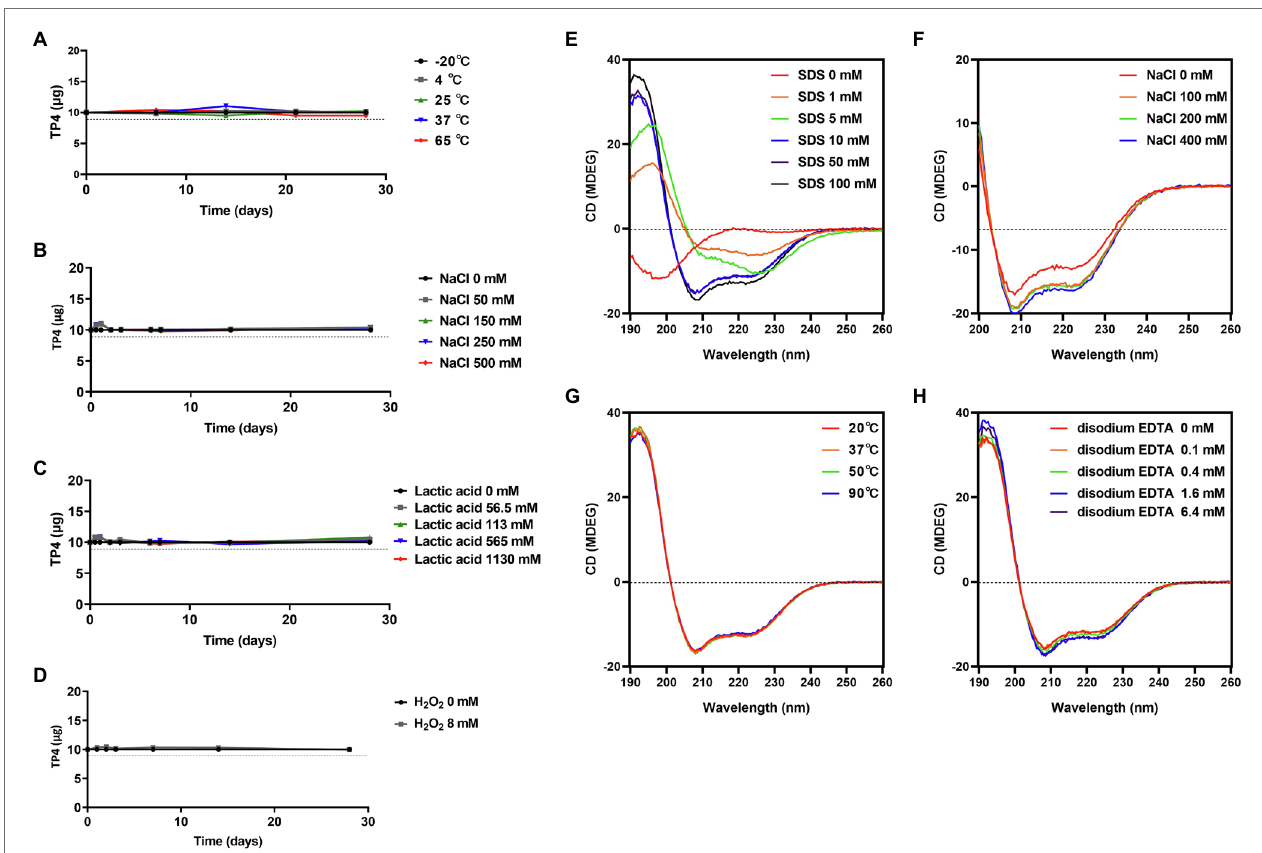
FIGURE 6 | Preformulation studies on TP4 peptide. High performance liquid chromatography (HPLC) of 500 μ g/ml TP4 peptide dissolved in various aqueous buffer solutions or conditions and kept for various times. (A) TP4 was stored at − 20, 4, 25, 37, and 65 ° C to evaluate the effects of temperature. (B) TP4 was incubated in different NaCl concentrations (0, 50, 150, 250, and 500 mM) to evaluate effects of ionic strength. (C) TP4 was stored in different lactic acid concentrations (0, 56.5, 113, 565, and 1,130 mM) to evaluate the effects of acidic physiological conditions. (D) TP4 oxidation was evaluated in 8 mM H 2 O 2 solution. The dotted line represents 90% stability. Data are representative of three independent experiments and values are expressed in mean ± SD. Circular Dichroism (CD) spectra of 145 μ g/ml TP4 peptide dissolved in the indicated concentrations of sodium dodecyl sulfate (SDS; E ), in 100 mM SDS plus the indicated concentrations of NaCl (F) , in 100 mM SDS at 20, 37, 50, and 90 ° C for 1 h (G) , or in 100 mM SDS plus the indicated concentrations of disodium EDTA (H)